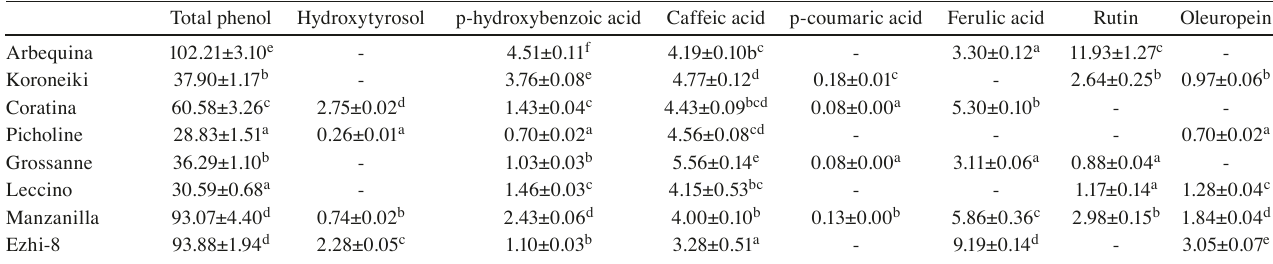
Tab. 7: Total phenol and phenolic composition in olive oil (mg/kg)